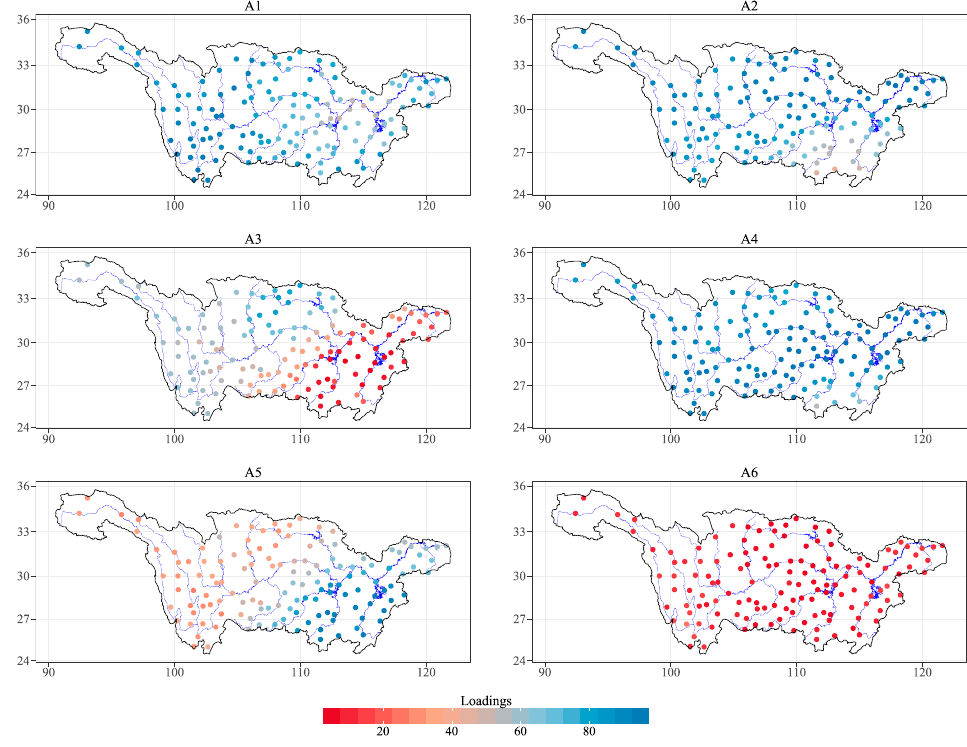
Figure 4. Loading patterns of archetypes for seasonal extreme precipitation across stations over the Yangtze River Basin.